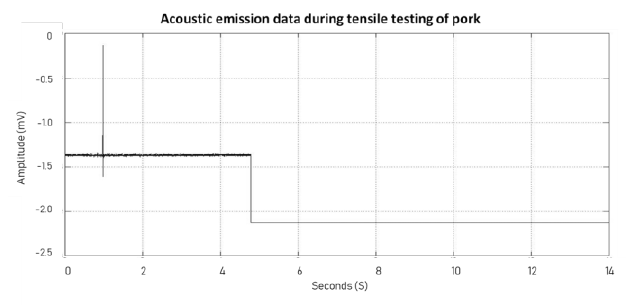
Figure 8. Amplitude against time (s) of tensile test on pork specimen. Data spike from “tapping” of load cell clearly displayed.